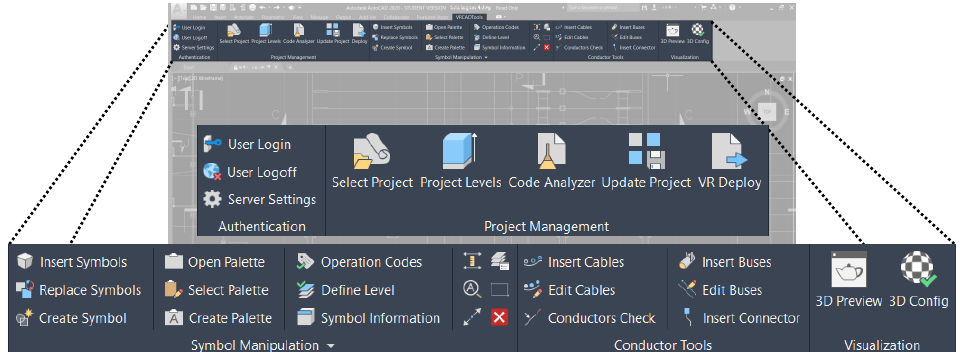
Figure 12. Shortcuts on the CAD Editor in Ribbon style developed on AutoCAD.